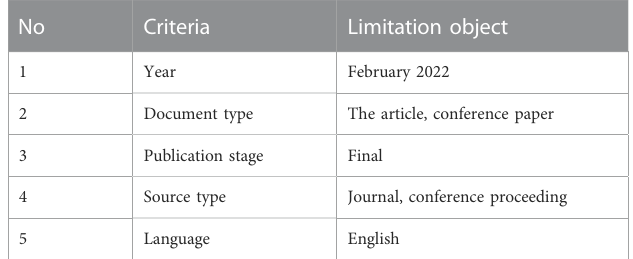
TABLE 2 Selection process using limitation